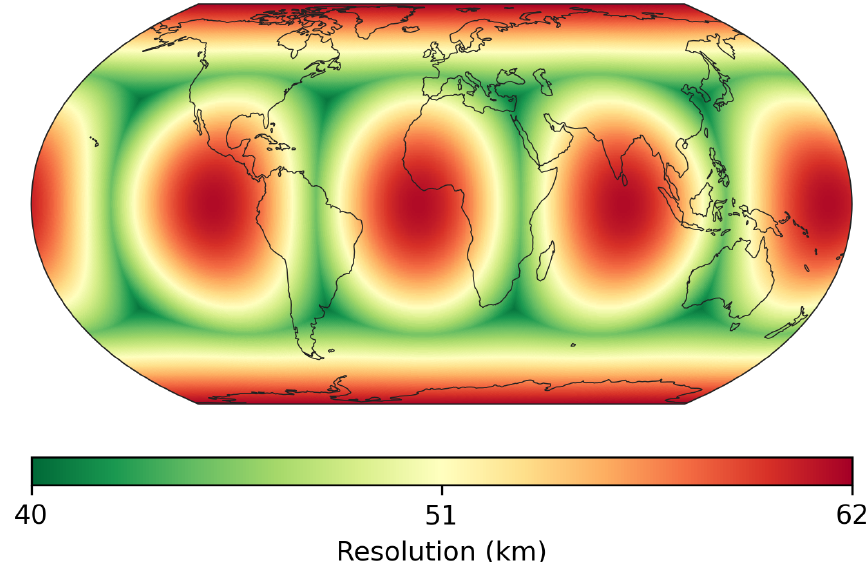
Figure A1. Variability of a C180 cubed sphere’s